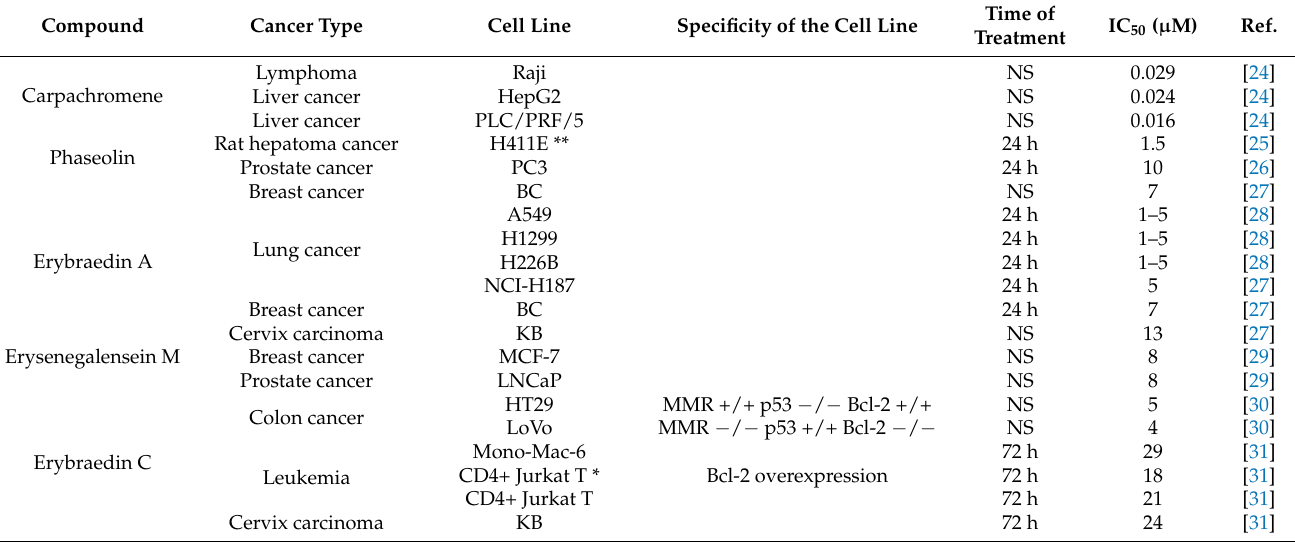
Table 2. In vitro cytotoxic activity of secondary metabolites isolated from E. senegalensis. *: mouse cell line; ** rat cell